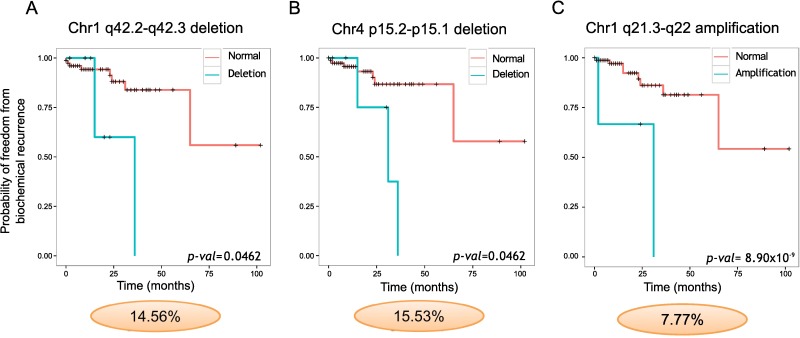
Minimal regions of deletion and amplification significantly associated with treatment failure.(A), 1q42.2-q42.3 deletion, (B) 4p15.2-p15.1 deletion, and (C) 1q21.3-q22 amplification. Kaplan-Meier freedom from biochemical recurrence are displayed. Log-rank test probabilities adjusted for multiple testing by the Benjamini-Hochberg method are indicated. Ovals indicate the frequency of alteration.